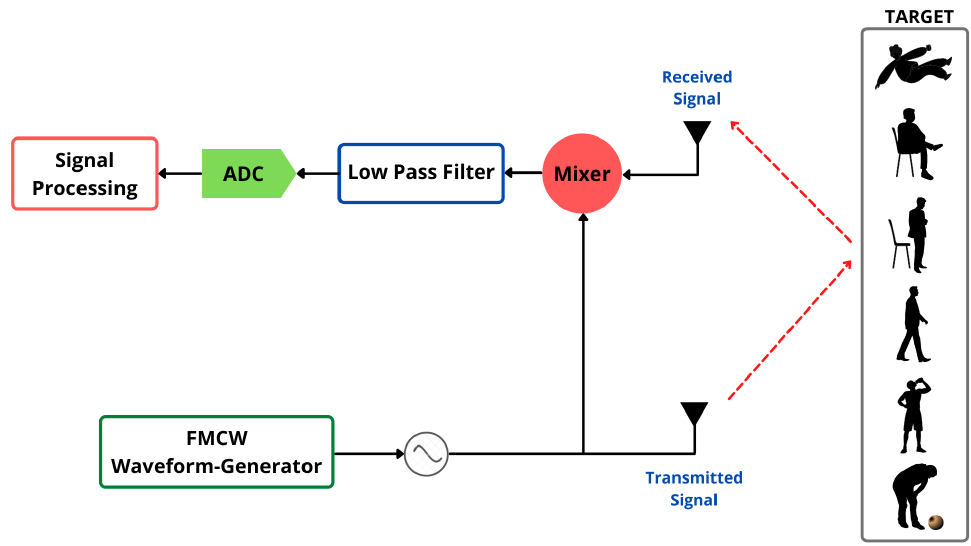
Figure 3. Block diagram of the FMCW RADAR scheme for distinct activity